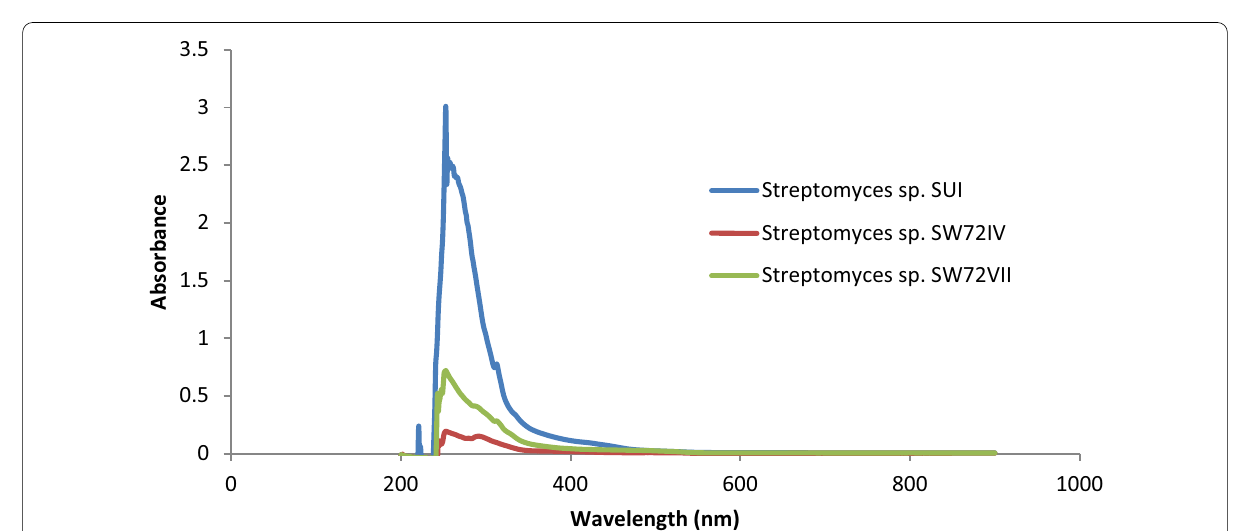
Fig. 3 UV–visible absorption spectrum of bioactive compounds produced by Streptomyces sp. SUI, Streptomyces sp. SW72IV and Streptomyces sp.